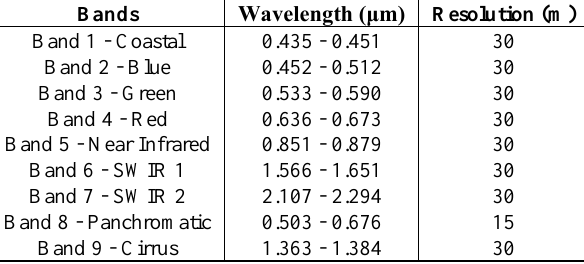
Table 1. Main characteristics of Landsat 8 OLI